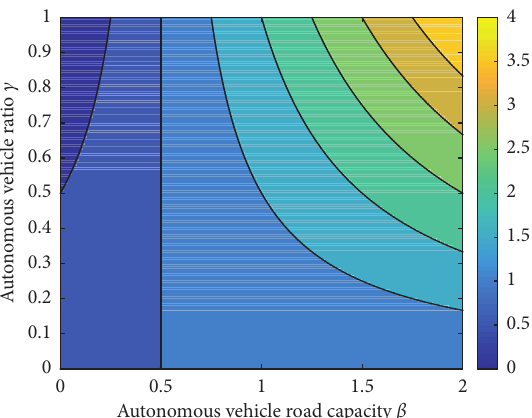
Figure 6: Peak traffic flow expansion factor: ζ � 1 − r + 2 r β